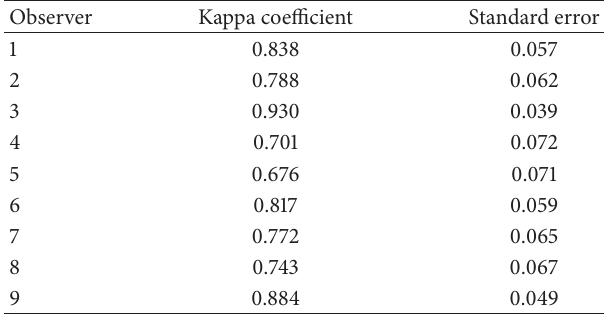
Table 1: Kappa coefficients for intrarater agreement between 𝑡 2 and 𝑡